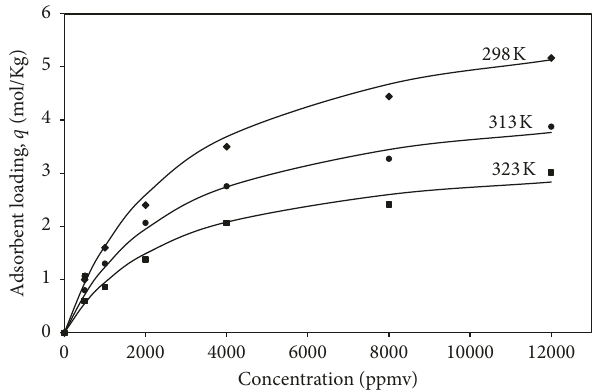
Figure 4: Adsorption isotherms of acetone on activated carbon at 298, 313, and 323K and at atmospheric pressure; symbols: ex- perimental adsorption data; solid lines: curves fittings using ex- tended Langmuir–Freundlich model. Table 1: Langmuir–Freundlich extended isotherm parameters for the adsorption of VOCs vapors on activated